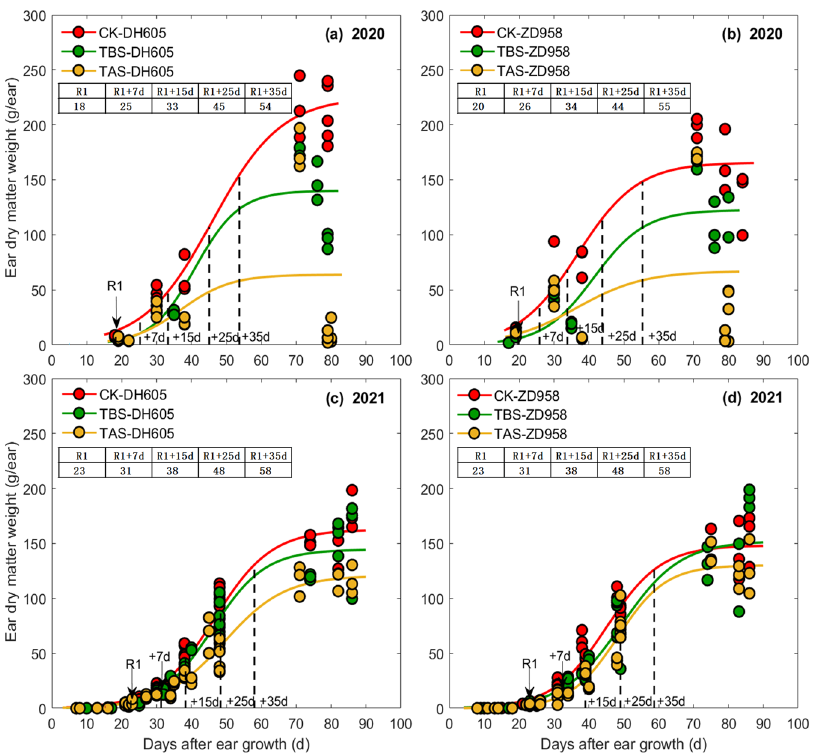
Figure 4. Ear dry matter weight of DH605 ( a,c ) and ZD958 ( b,d ) at different development stages under different heat stress treatments in 2020 ( a,b ) and 2021 (c,d) .